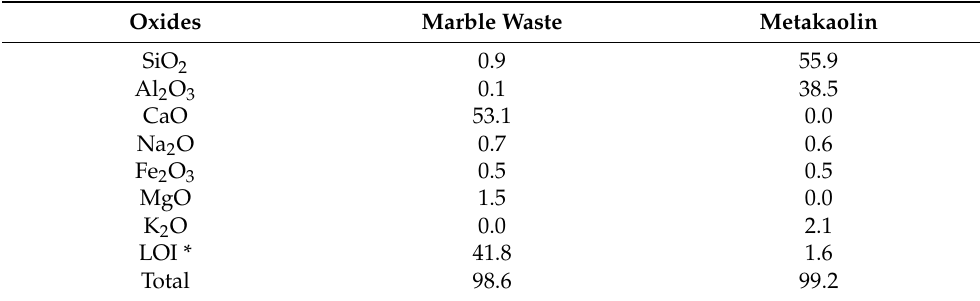
Table 2. Chemical composition (wt. %) of raw